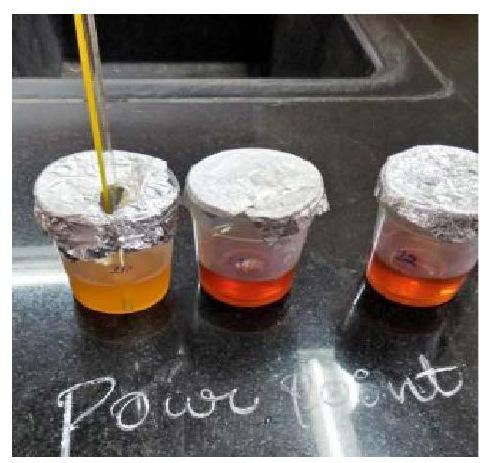
Figure 3: Experimental setup for Kinematic Viscosity test as per IS:1448 (Part-25) standards.